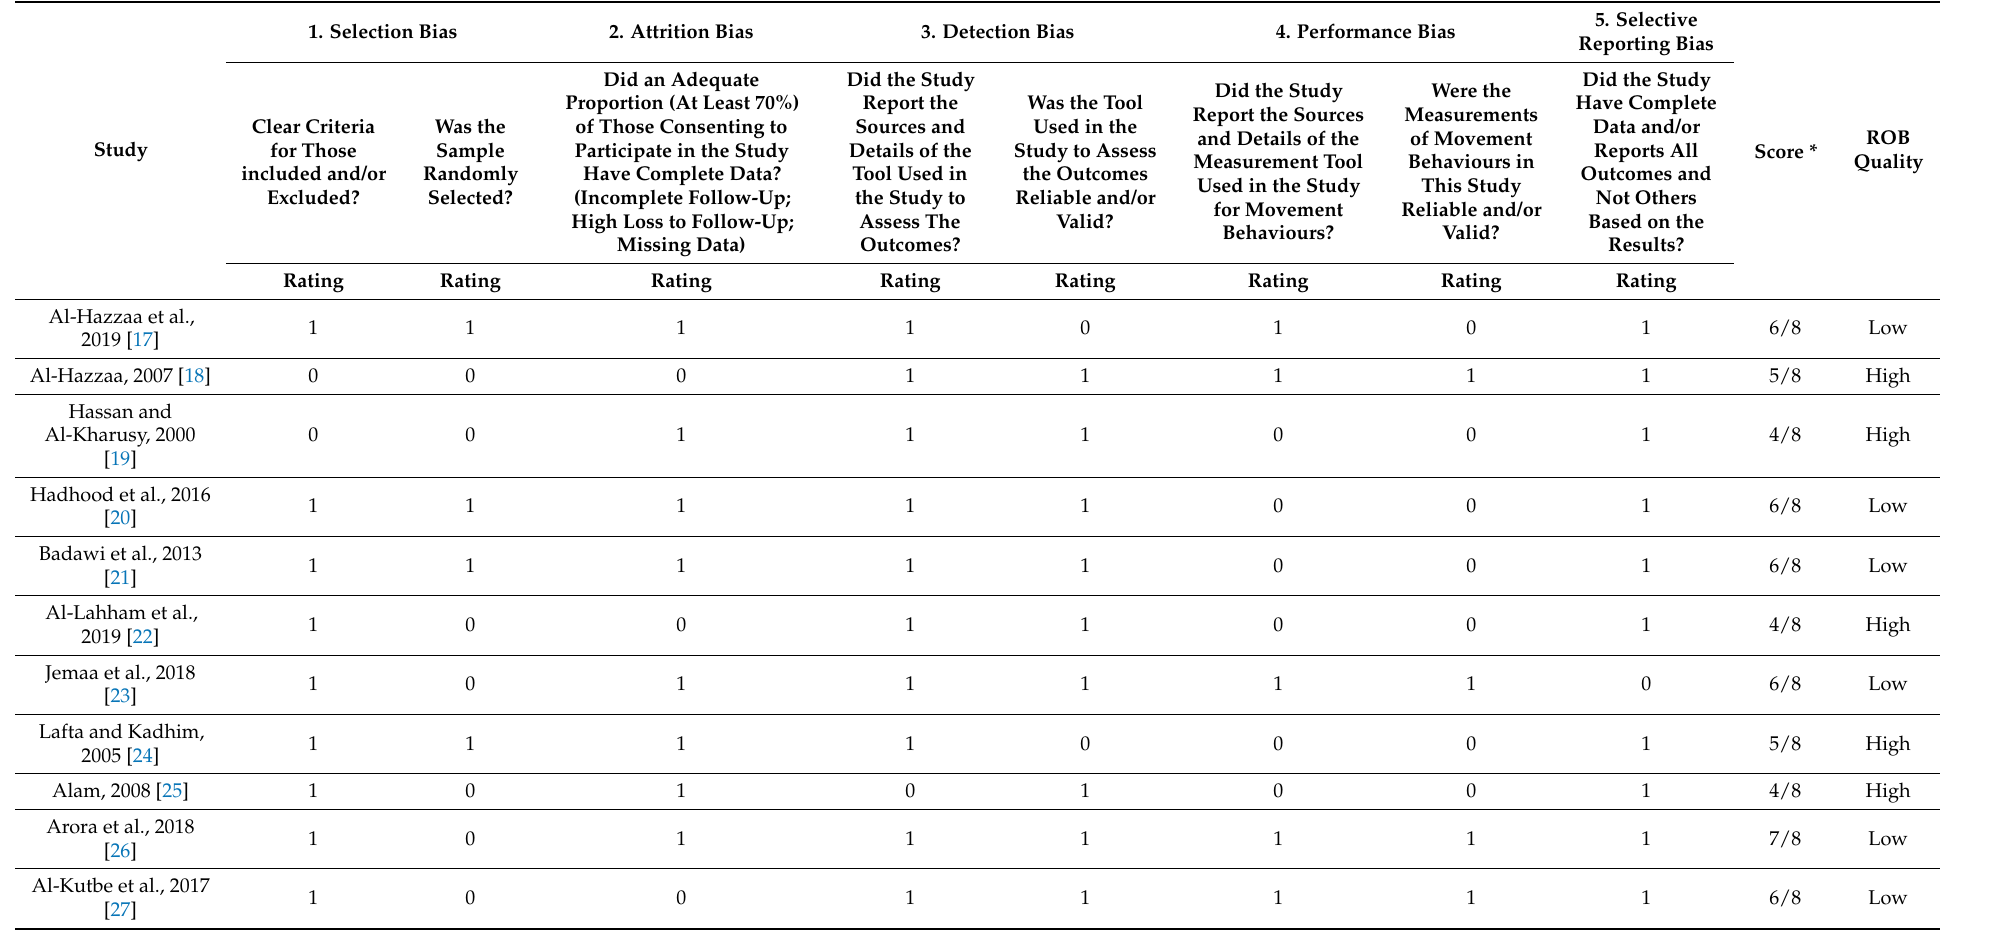
Table 2. Risk of bias for included